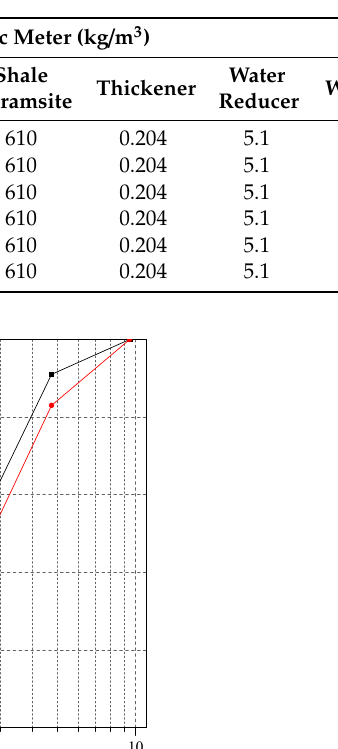
Table 1. Mix proportions for concrete.